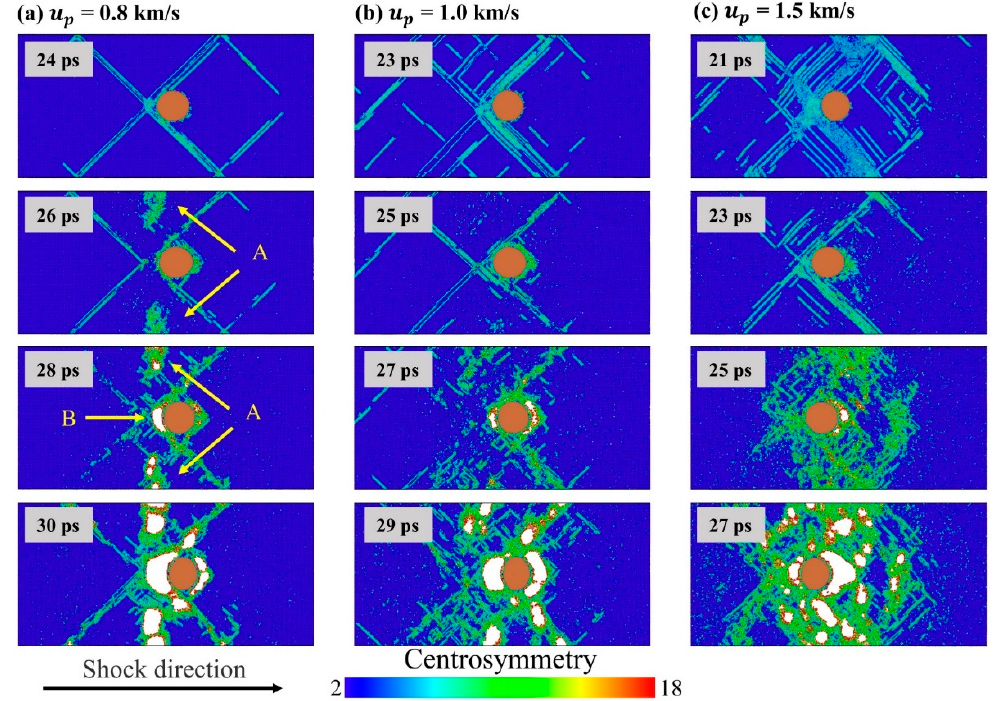
Figure 8. Microstructure evolutions of Al–Cu during spallation process. The Al atoms are color-coded by CSP. ( a ) u p = 0.8 km/s; ( b ) u p = 1.0 km/s; ( c ) u p = 1.5 km/s.